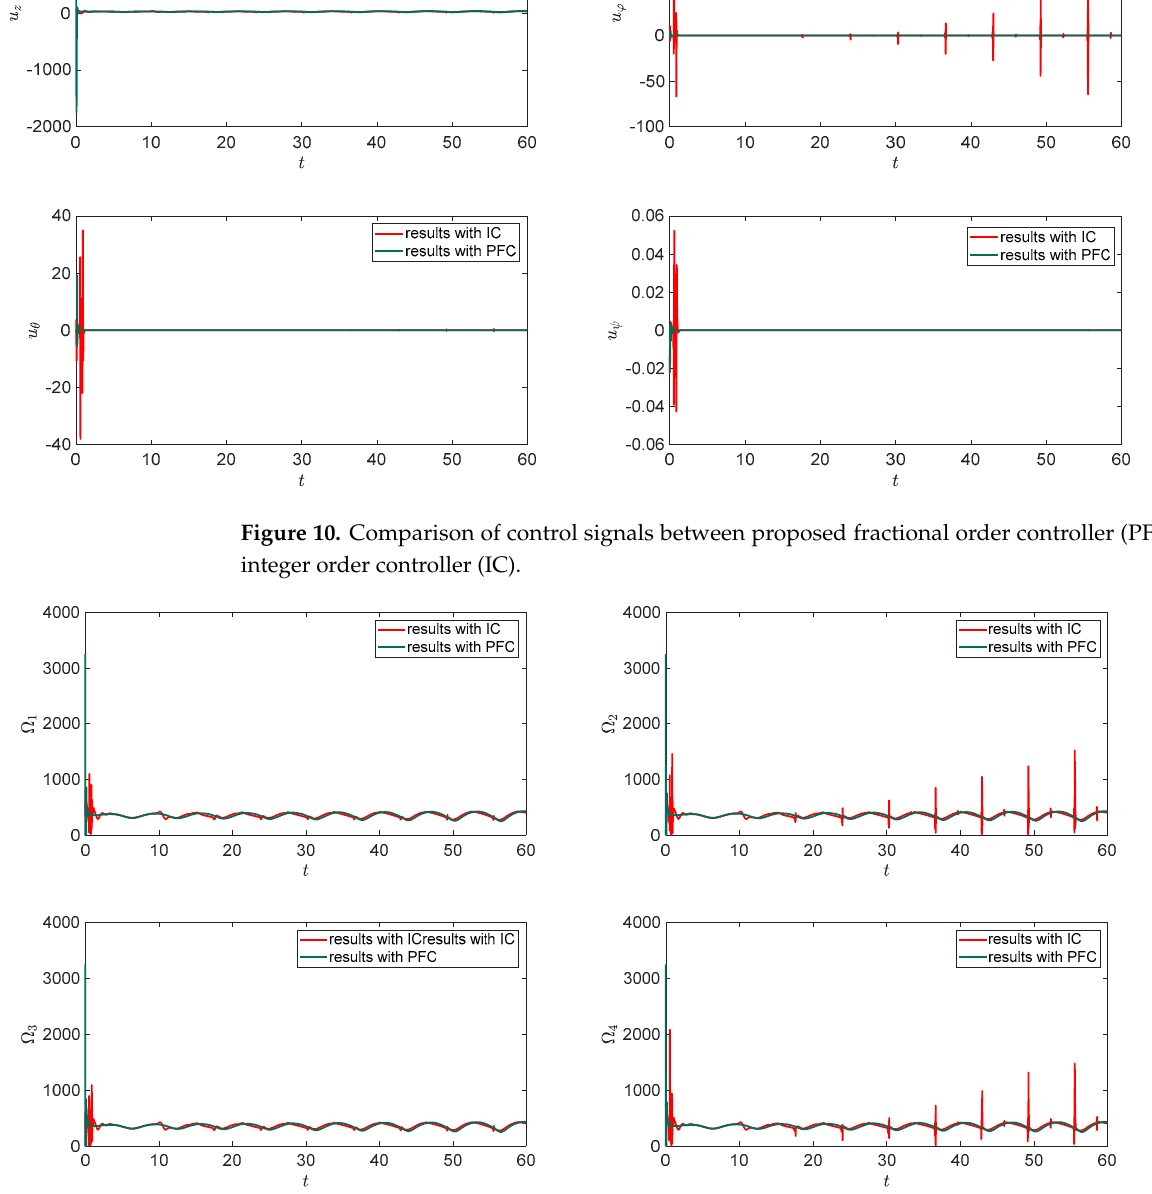
Figure 11. Comparison of rotor speeds between proposed fractional order controller (PFC) and integer order controller (IC).